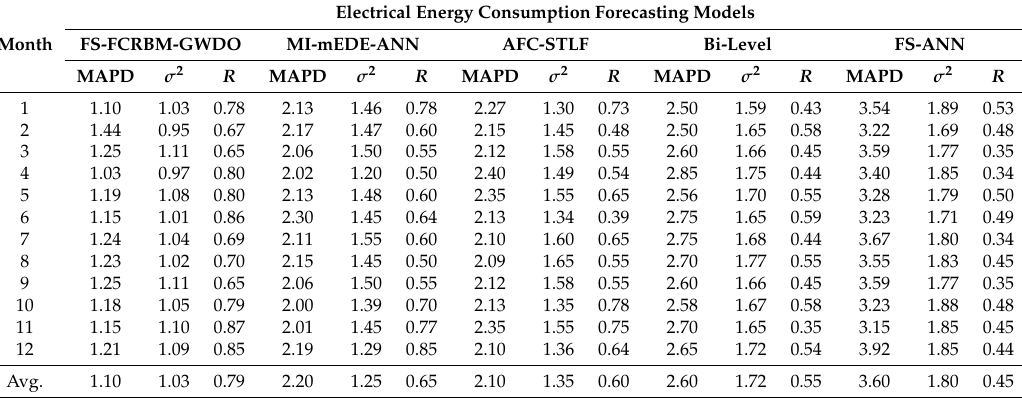
Table 4. FE power grid results of the leap year 2016: comparative performance analysis of the FS-FCRBM-GWDO and existing models in terms of MAPD, correlation coefficient and